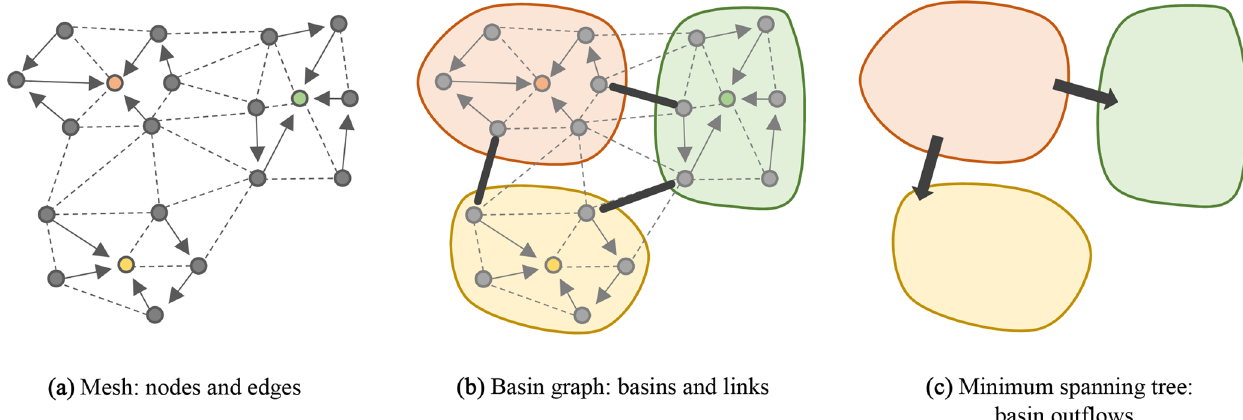
Figure 2. Illustration of the inputs and the first steps of the proposed flow routing algorithm. (a) The input topography is defined on top of a mesh by a set of nodes and edges. A single edge is selected for each node, it connects the node to its flow receiver, i.e., its neighbor with the steepest slope. Nodes with no receiver are local minima (colored in the figure). (b) All the nodes that flow to a same local minimum belong to the same basin. A graph of basins is created by connecting together adjacent basins with links , which are materialized on the mesh by edges representing the passes, i.e., the crossings of lowest elevation that connect each pair of basins (black thick arrows). (c) Some of the links are selected by computing a minimum spanning tree and the corresponding passes are oriented in the direction of the flow across the basins (unidirectional arrows). This structure is then used to update the flow receivers so that the flow reaches the domain boundaries without being